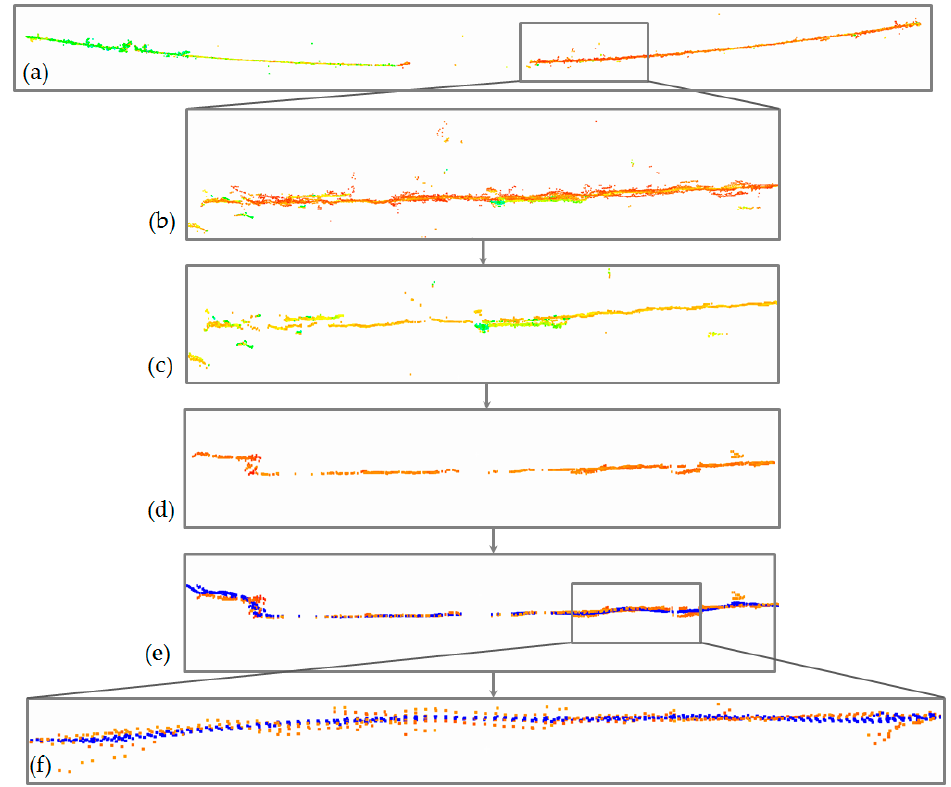
Figure 16. Power line (data set III) at different stages of the proposed algorithm: ( a ) the original point cloud, ( b ) close-up, ( c ) the results of coarse filtration with intensity condition, ( d ) the results of coarse filtration with geometric condition, ( e ) points denoised with the use of wavelet analysis ( f ) close-up of wavelet analysis results.